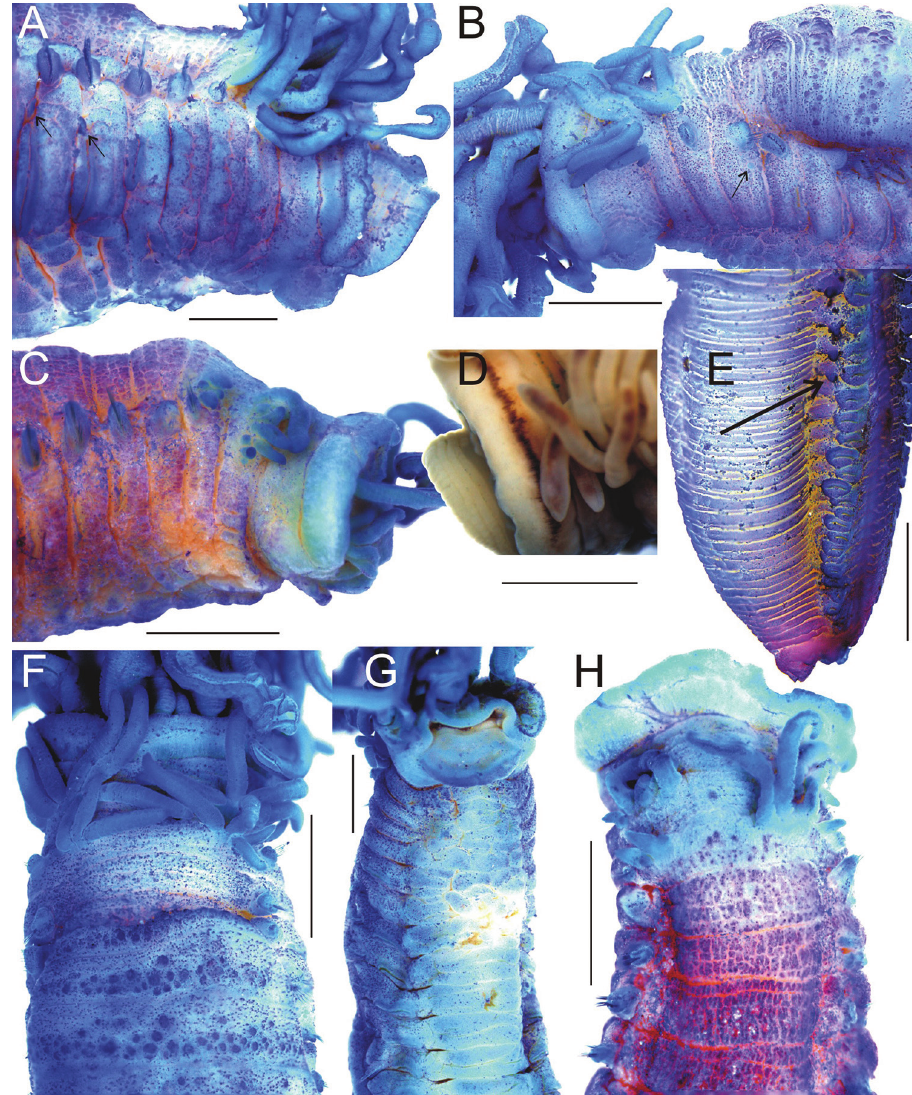
Figure 6. Thelepus marthae sp. n. external morphology. A–C lateral view of anterior end (arrowed ne- phridial papillae) D detail of anterior end, showing pigmented eyespots E lateral view of posterior end (arrowed last segment with notochaetae) F, H dorsal view of anterior end G ventral view of anterior end. A SP-22 st.60 B, F, G holotype C, H Alaid 30.3 D, E SP-22 st. 72. Scale bars: 1 mm. All worms but D stained with methylene